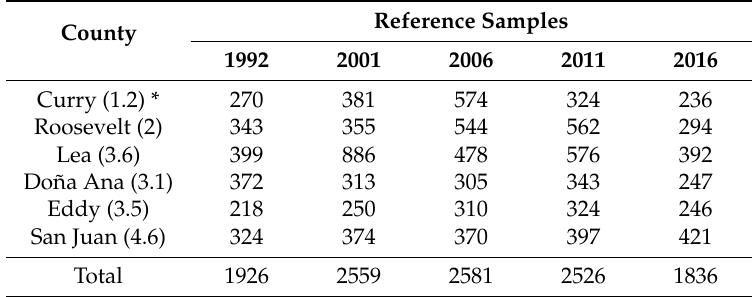
Table 4. Summary of reference sample collected over each county and each year of the NLCD map. Reference Samples County